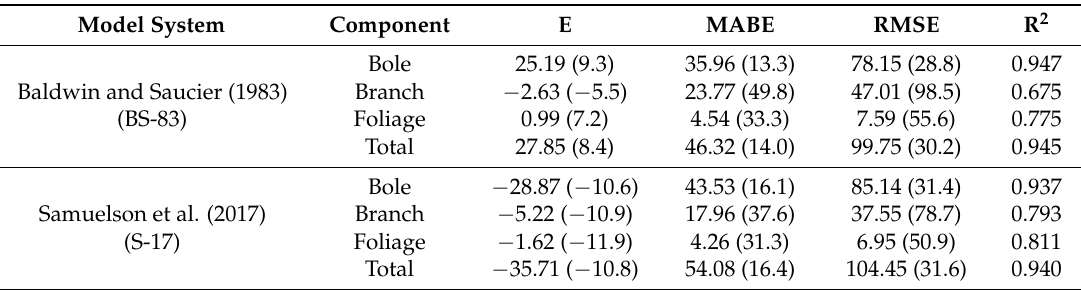
Table 11. Prediction statistics for each component using biomass equations developed by Baldwin and Saucier (1983) and Samuelson et al. (2017).